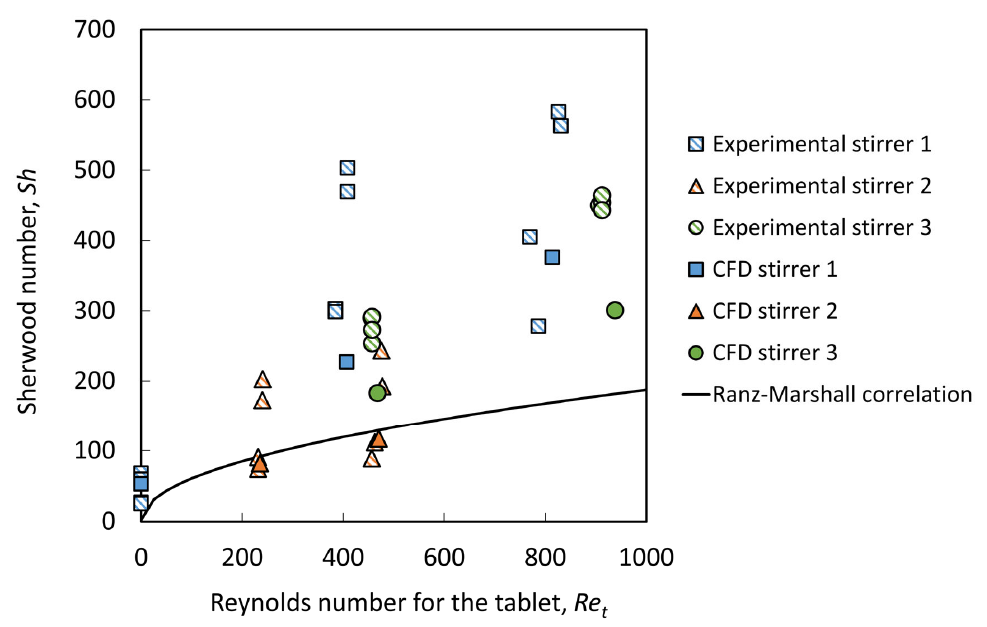
Figure 10. The relationship between the Sherwood number and Reynolds number for the tablet achieved from experimental and simulation results. The experimental data are taken from Langrish et al. [23].